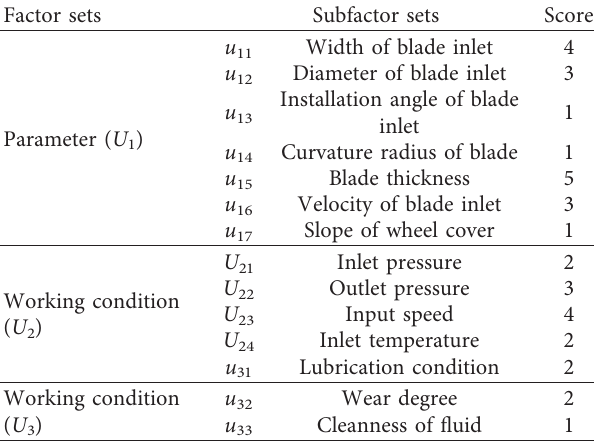
Table 4: Factor set, subfactor set, and the rating scale. Factor sets